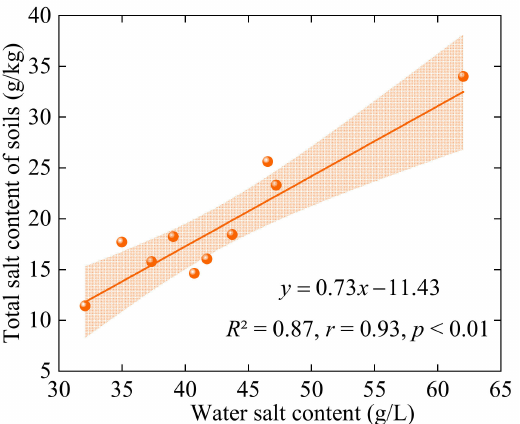
Figure 3. The relationship the total salt content of the 0–100 cm soils and water salt